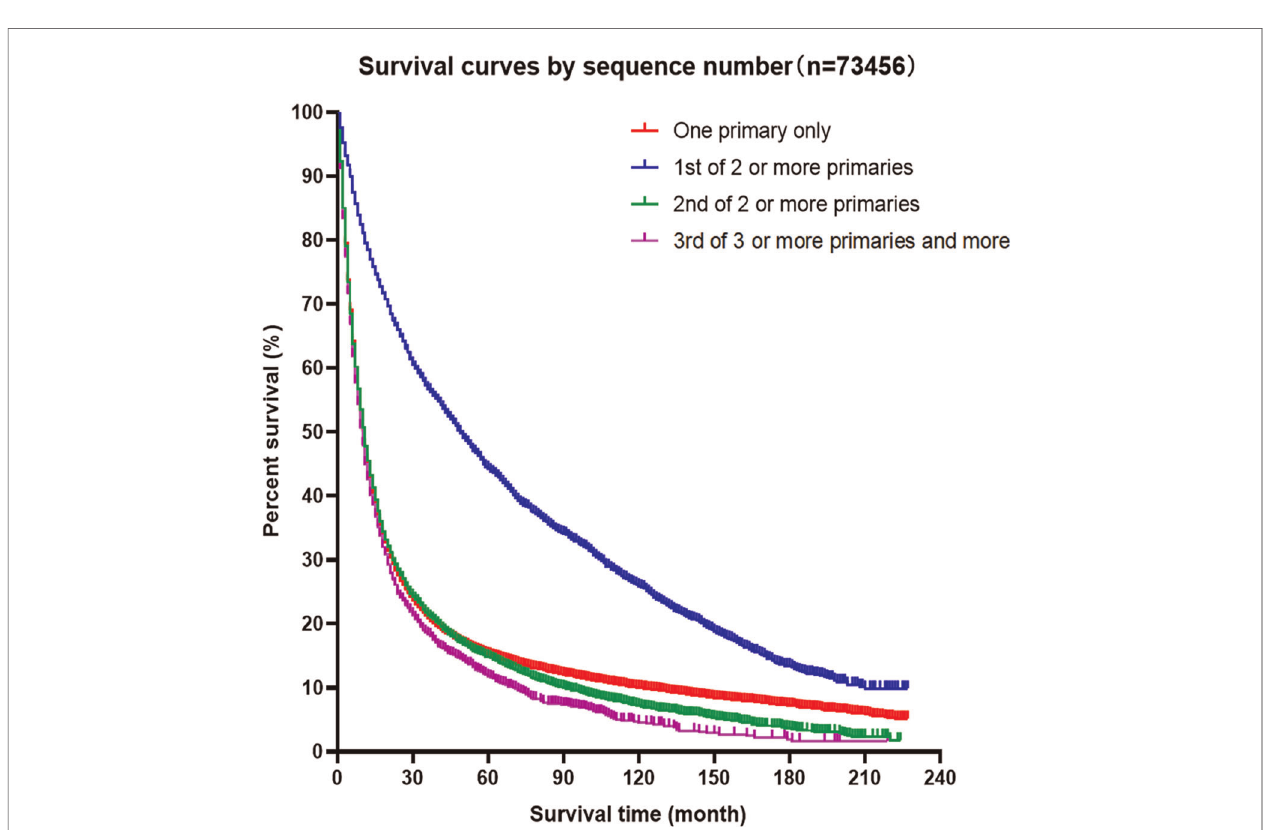
FIGURE 2 | Kaplan – Meier survival curves for patients with esophageal cancer, according to sequence number.